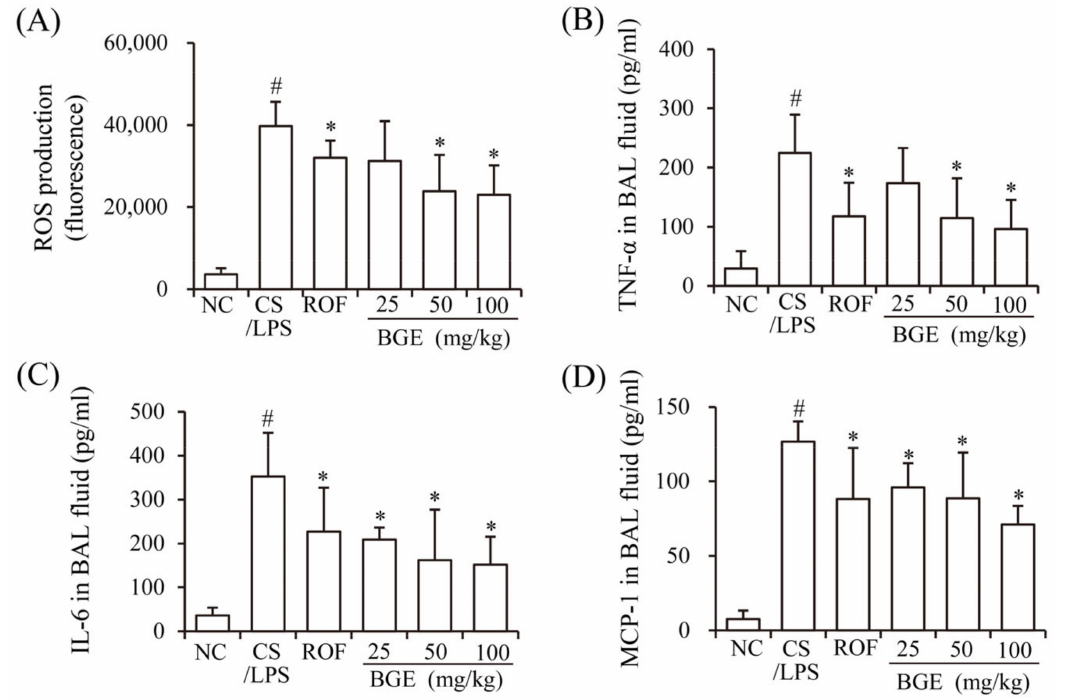
Figure 1. Effects of the black ginseng extract (BGE) on airway inflammatory responses in in CS/LPS- treated lung inflammation mice model. ( A ) ROS level of bronchoalveolar lavage (BAL) fluid was determined using 2 (cid:48) , 7 (cid:48) -dichlorofluorescin diacetate (DCF-DA); ( B – D ) The TNF- α , IL-6, and MCP-1 levels of BAL fluid were determined using ELISA kits. Roflumilast (ROF) was used as a positive control agent. NC: normal control mice; CS/LPS: CS/LPS-treated mice; ROF: 5 mg/kg ROF-treated CS/LPS mice; BGE 25: 25 mg/kg BGE-treated CS/LPS mice; BGE 50: 50 mg/kg BGE-treated CS/LPS mice; and BGE 100: 100 mg/kg BGE-treated CS/LPS mice group. The values are expressed as means ± standard deviation (SD) ( n = 6). # p < 0.01: significantly different compared with NC; * p < 0.05: significantly different compared with CS/LPS-induced